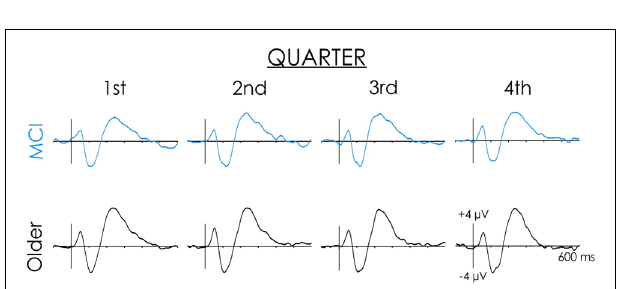
FIGURE 4 | Healthy older adult and MCI grand averaged ERP waveforms across the four quarters of the slow rate of presentation condition. Data presented are from the Cz electrode site. Note the N1 and P2 did not change across the four quarters for either healthy older adults or people with